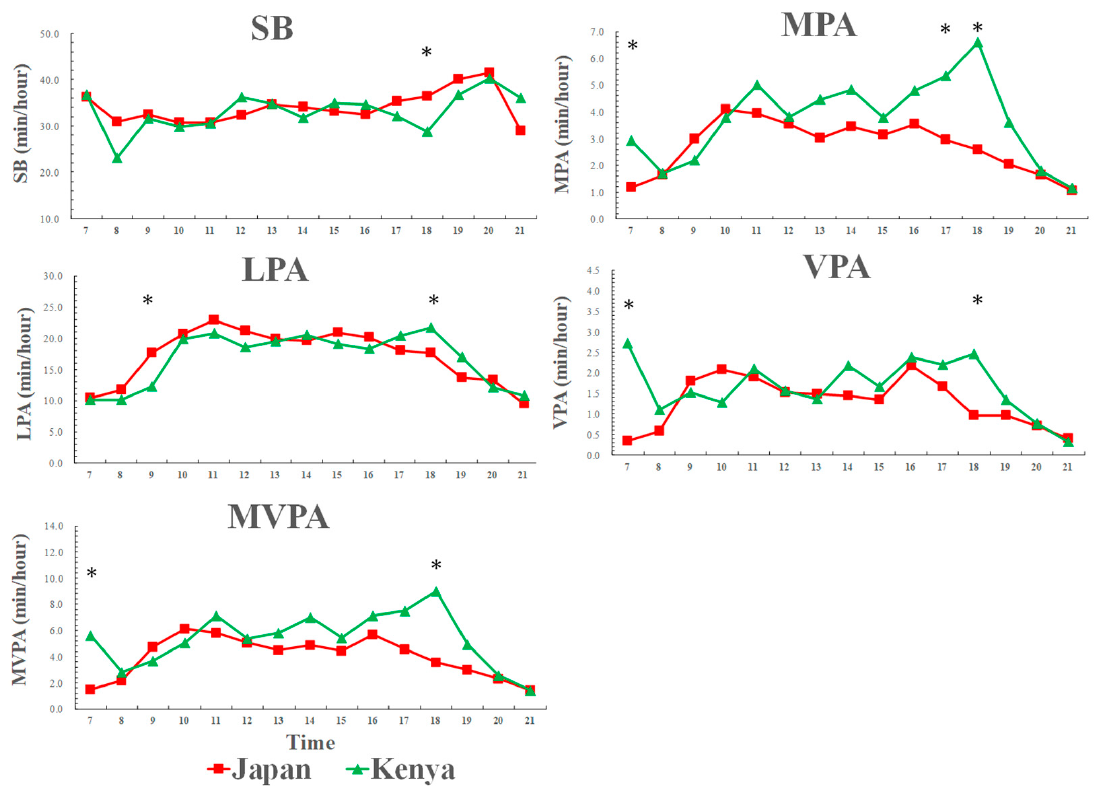
Figure 3. Weekend physical activity and sedentary behavior patterns across a day among Kenyan and Japanese boys.